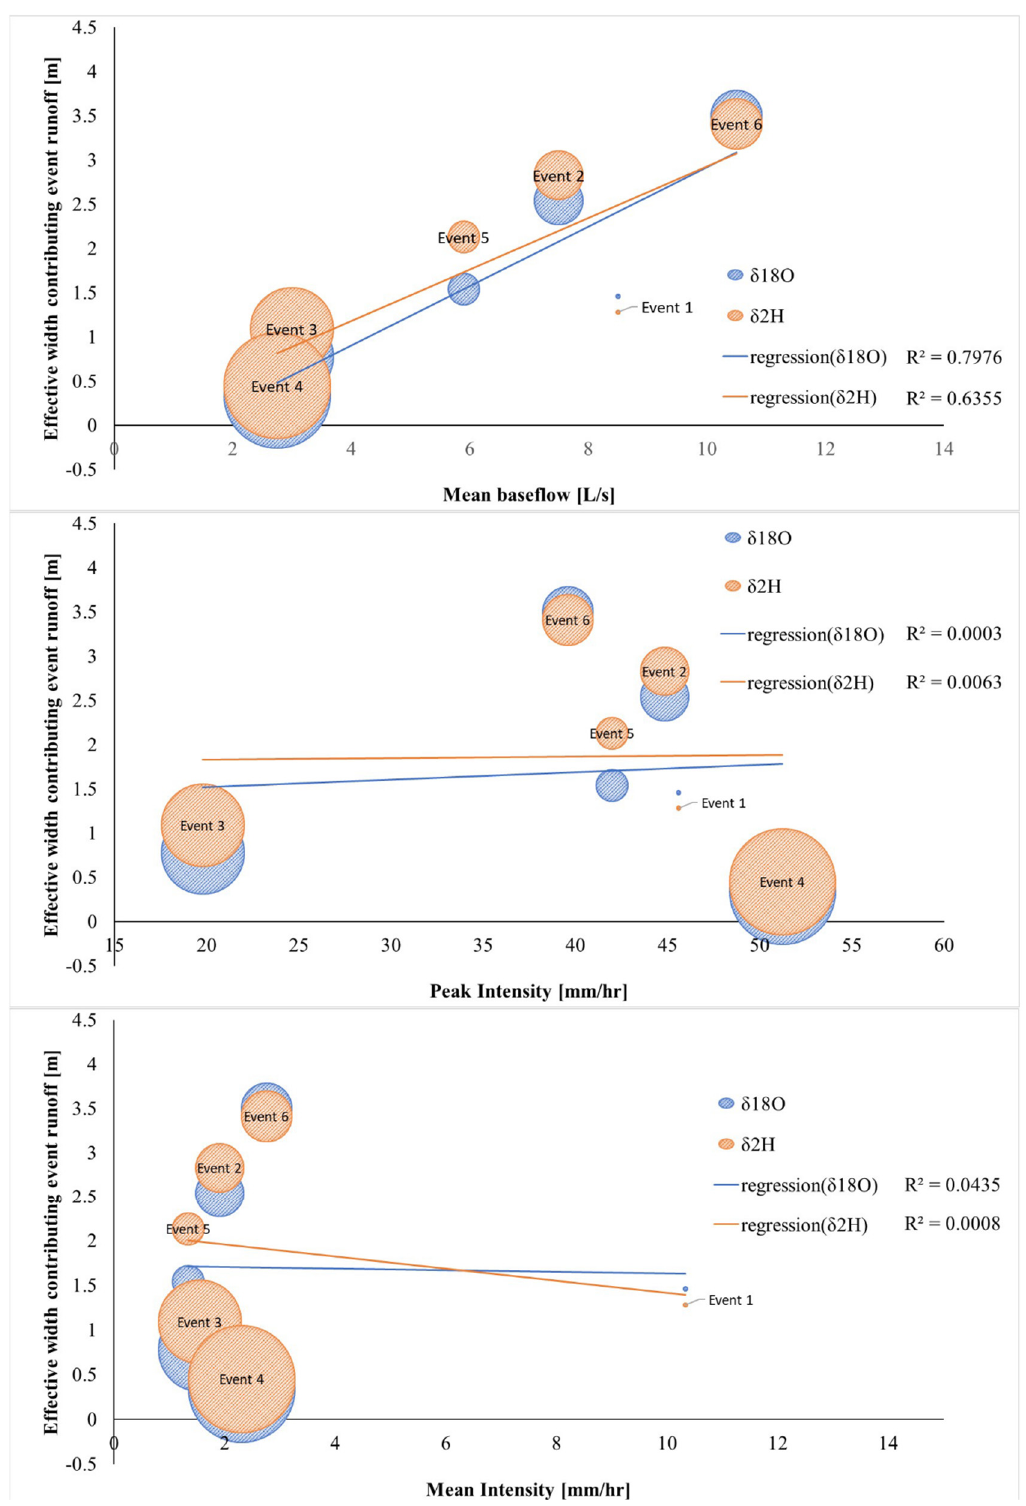
Figure 8. Linear regression analysis between Contributing Area per channel length and mean base flow, mean intensity and peak intensity, bubble size indicates API7 (mm).